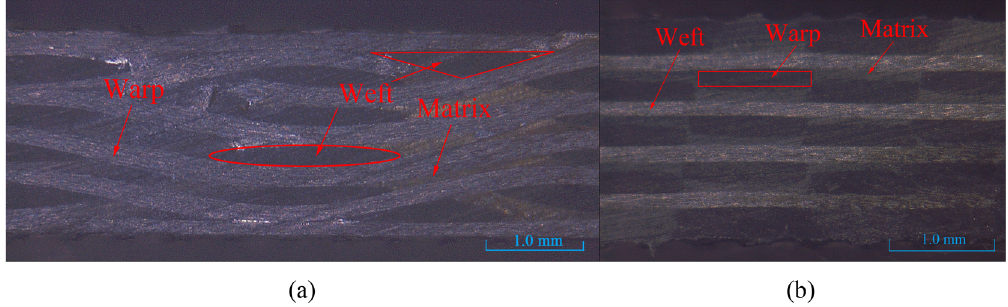
Figure 1: Sectional view of 2.5D woven composites: orientation of ( a ) warp yarns and ( b )